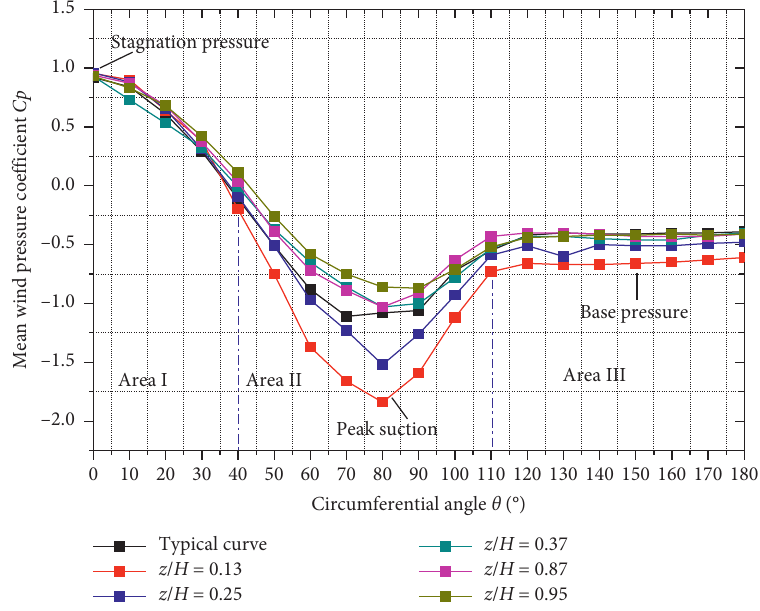
Figure 5: Mean pressure coefficients at typical height.